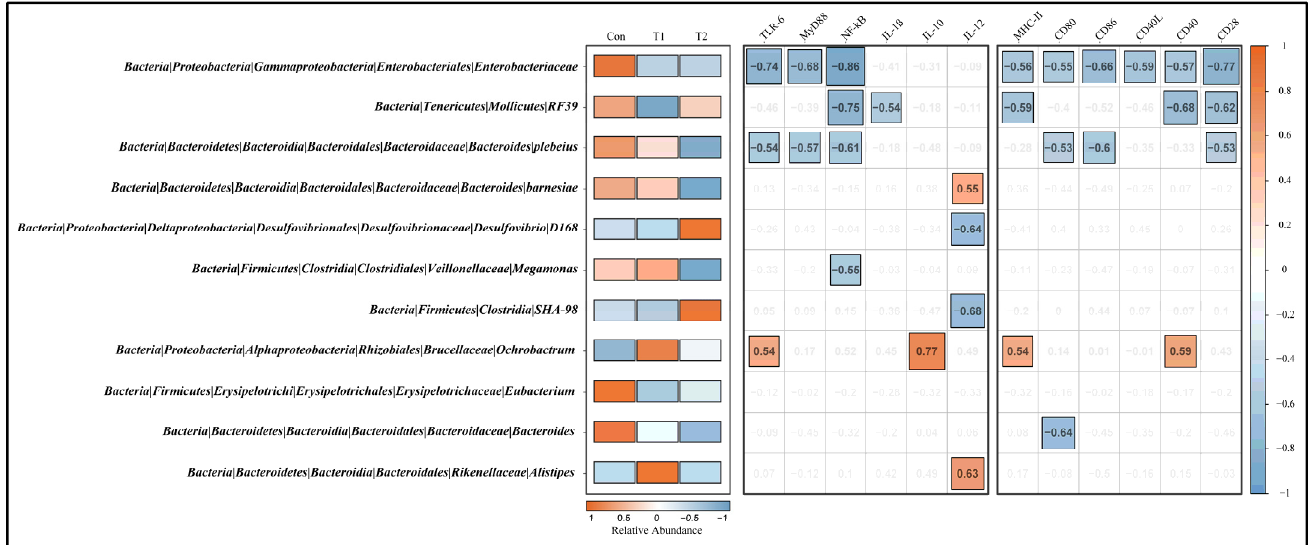
Figure 6. The correlation analysis was performed between the signature microbiota (cecal) and differential immune-related gene expression (cecal tonsil). From left to right: genus names; the relative abundance of the genera in different groups. The darker the orange, the higher the relative abundance, while the darker the blue, the lower the relative abundance. The correlation between gene expression and signature microbiota. The orange squares represent positive correlation, blue squares represent negative correlation, while blank squares represent no significant difference (n.s.).